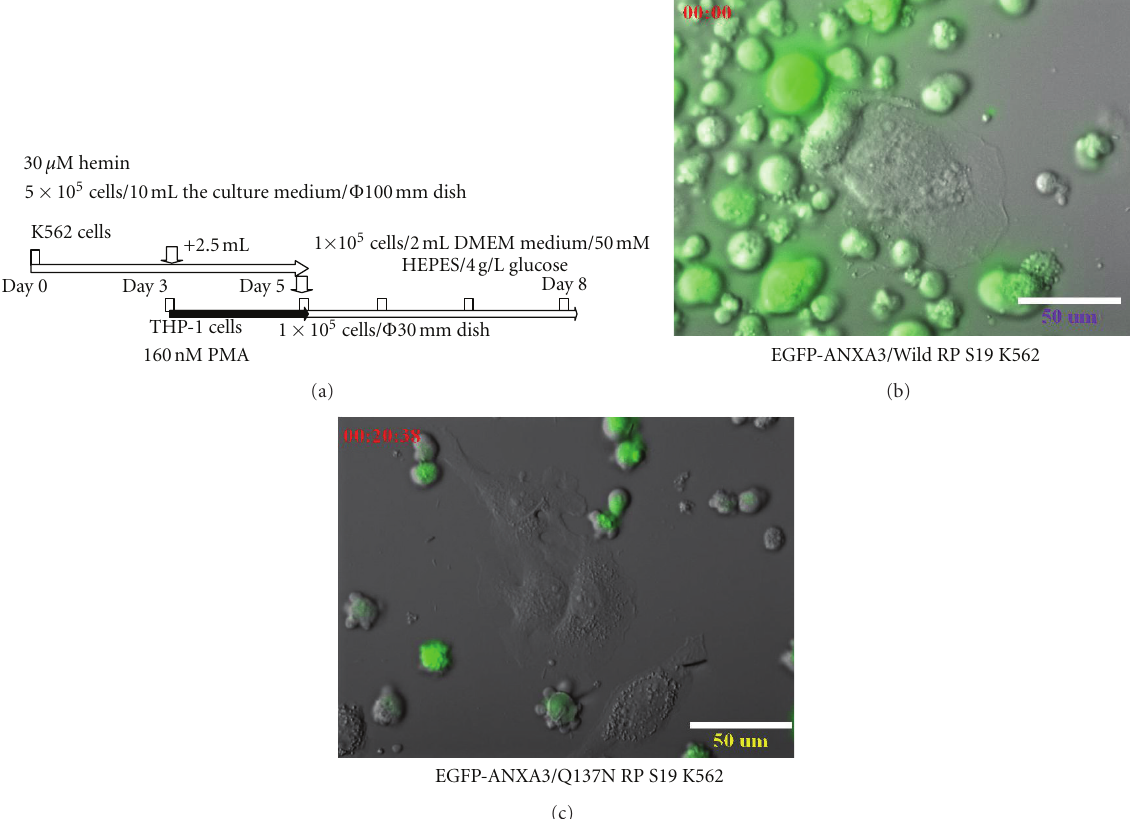
Figure 6: Detection of the contribution of the K562-THP-1 cell interaction to the haemin-induced terminal di ff erentiation of K562 cells using time-lapse microscopy. (a) Time schedule for the K562 cells that were cocultured with the THP-1 cells. K562 cells expressing EGFP- ANXA3/Wild-type RP S19 (b) and EGFP-ANXA3/Gln137Asn mutant RP S19 (c) were cultured with the THP-1 macrophage-like cells for 1–3 days and monitored using the LCV110 microscope ( n =